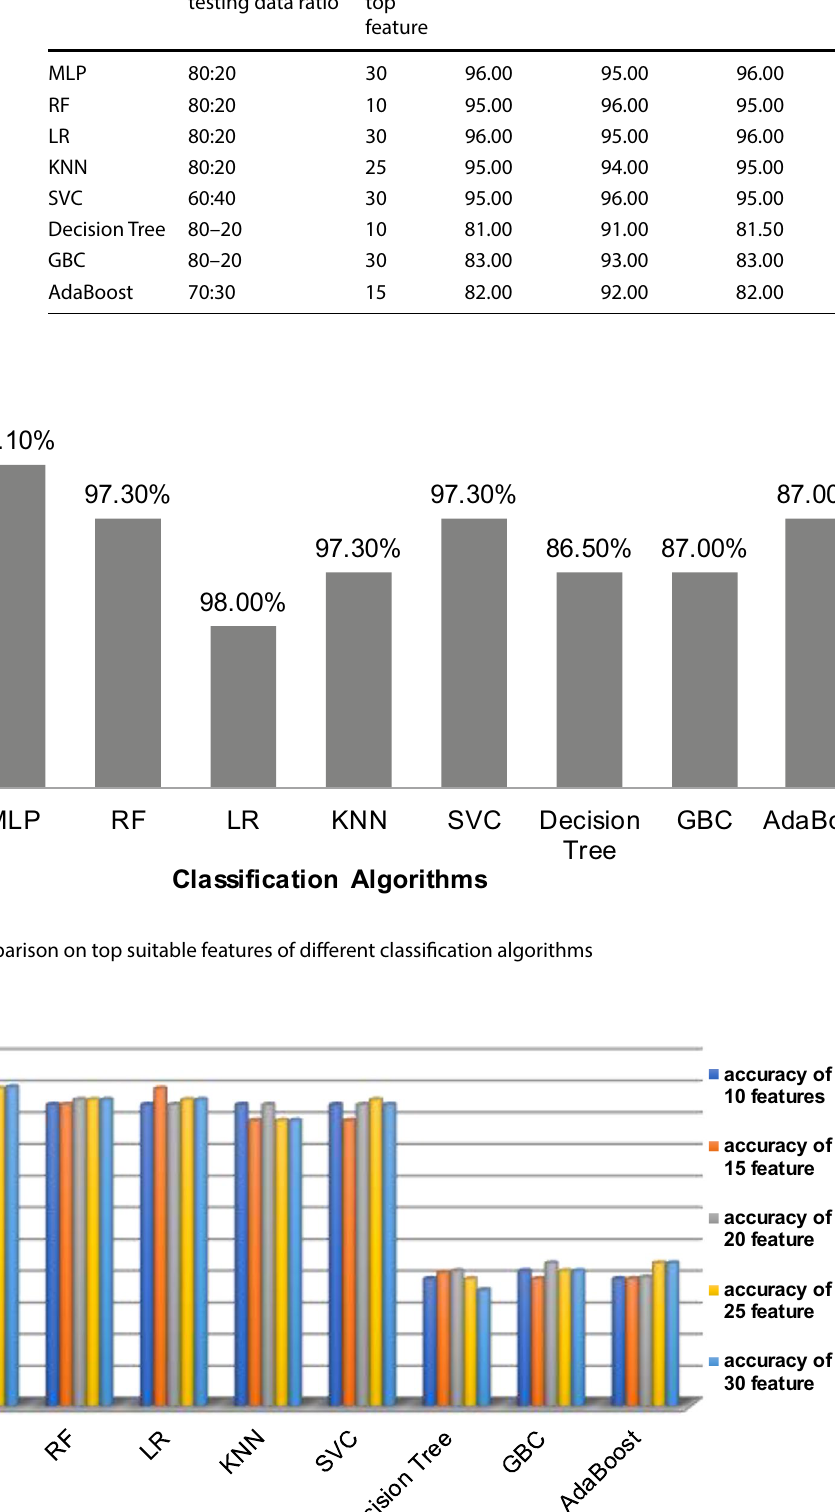
Table 8 Lowest performance comparison of different